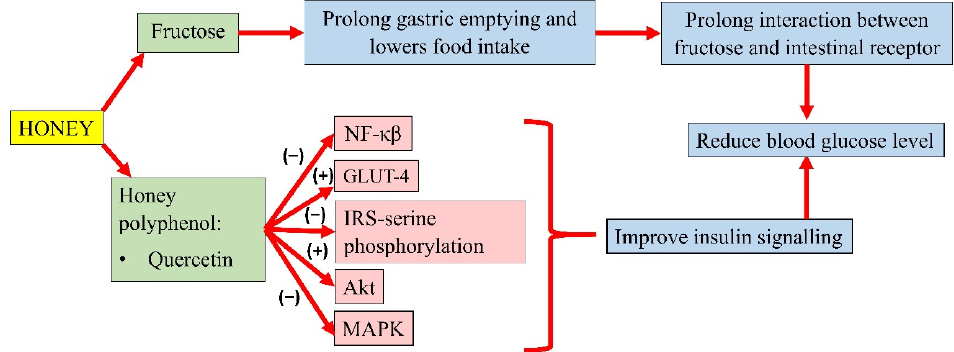
Figure 2. Summary of the antihyperglycemic properties of honey. NF- κ B, nuclear factor kappa B; GLUT-4, insulin-independent glucose transporter 4; IRS-serine phosphorylation, inhibiting insulin receptor substrate-serine phosphorylation; Akt, protein kinase B; MAPK, mitogen-activated protein kinase; ( − ), inhibit; (+), increase.